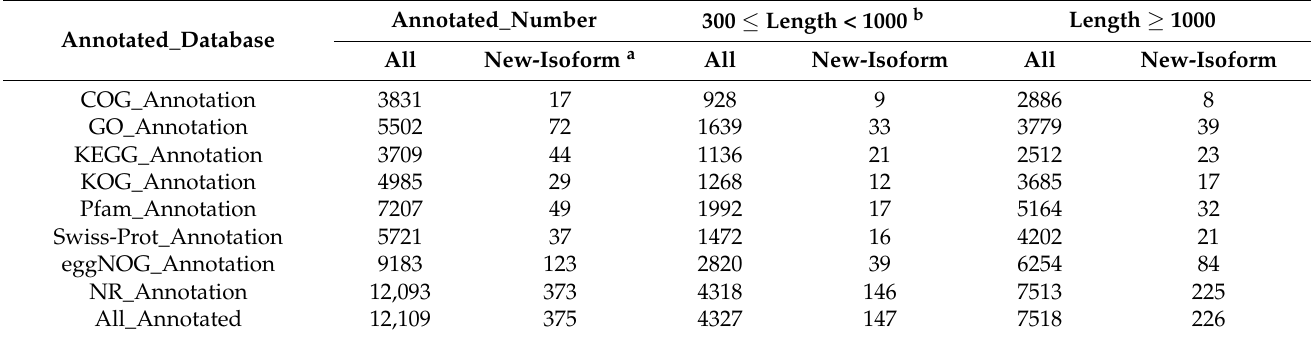
Table 1. Functional annotation of G. lucidum deduced proteins by sequence similarity